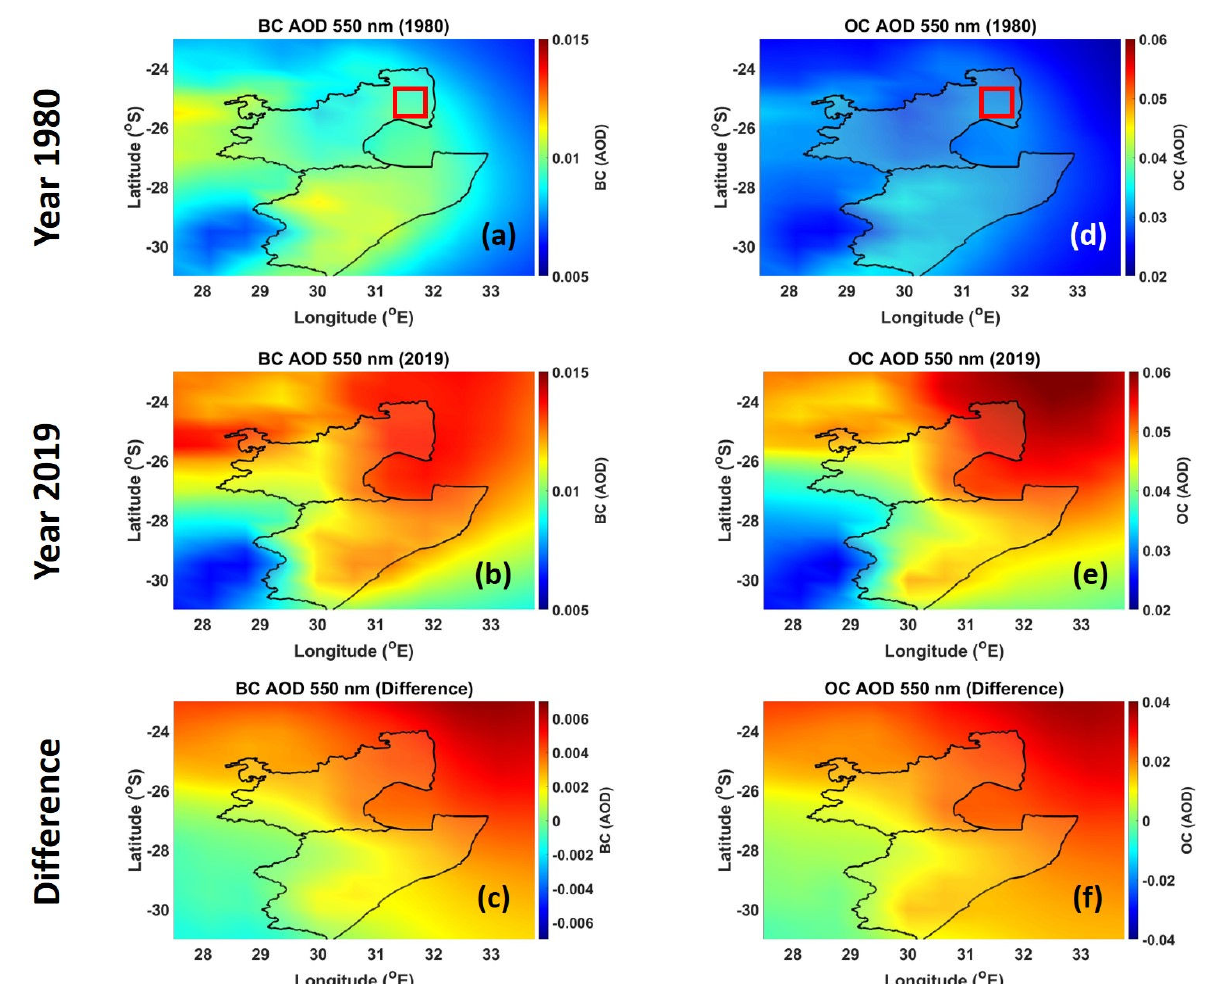
Figure 2. BC AOD over the KwaZulu Natal and Mpumalanga provinces during ( a ) 1980, ( b ) 2019, and ( c ) the difference between 2019 and 1980. OC AOD over the KwaZulu Natal and Mpumalanga provinces during ( d ) 1980, ( e ) 2019, and ( f ) the difference between 2019 and